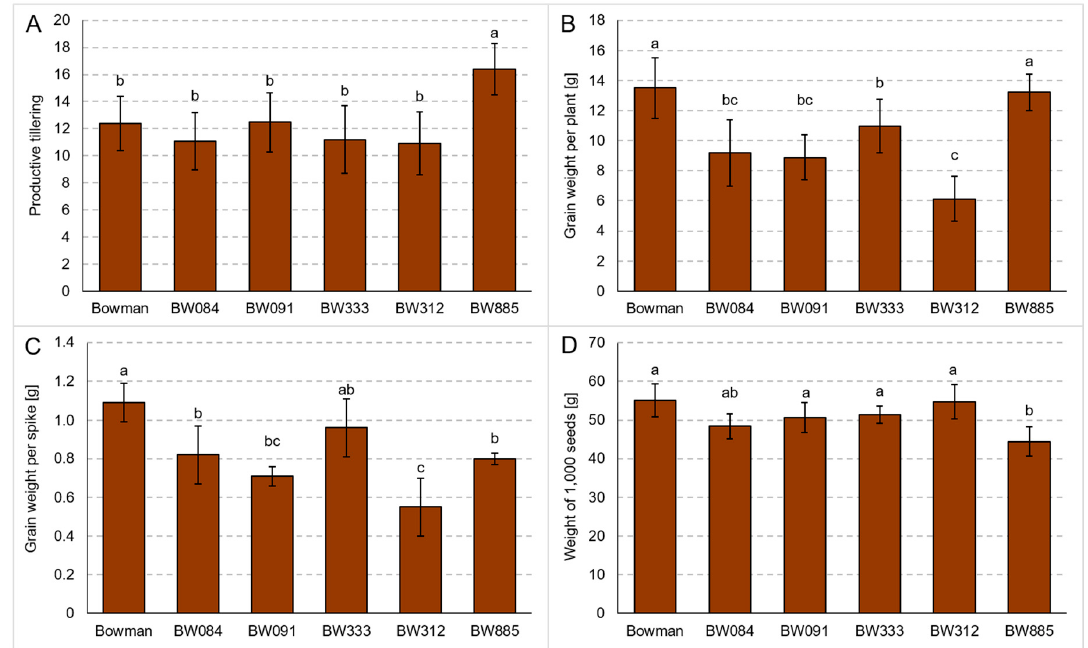
Figure 8. Productive tillering and yield parameters of the analyzed genotypes under the field conditions: productive tillering ( A ), average grain weight per plant ( B ), average grain weight per spike ( C ), and weight of 1000 seeds ( D ). The mean values ± (SD) marked with the same letters are not significantly different, according to Duncan’s test ( p ≤ 0.05). Details are given in the text.